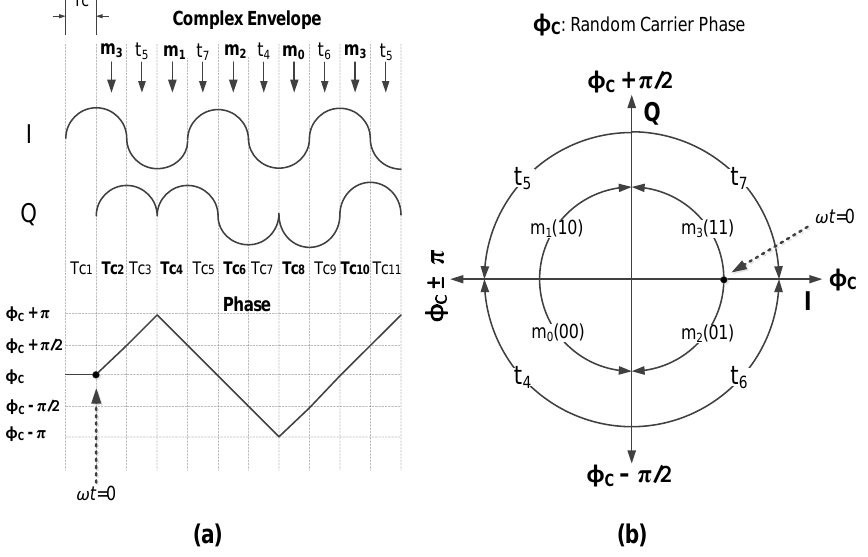
Figure 5. Phase transitions of the complex envelope. ( a ) Example phase transition sequence; ( b ) All possible phase